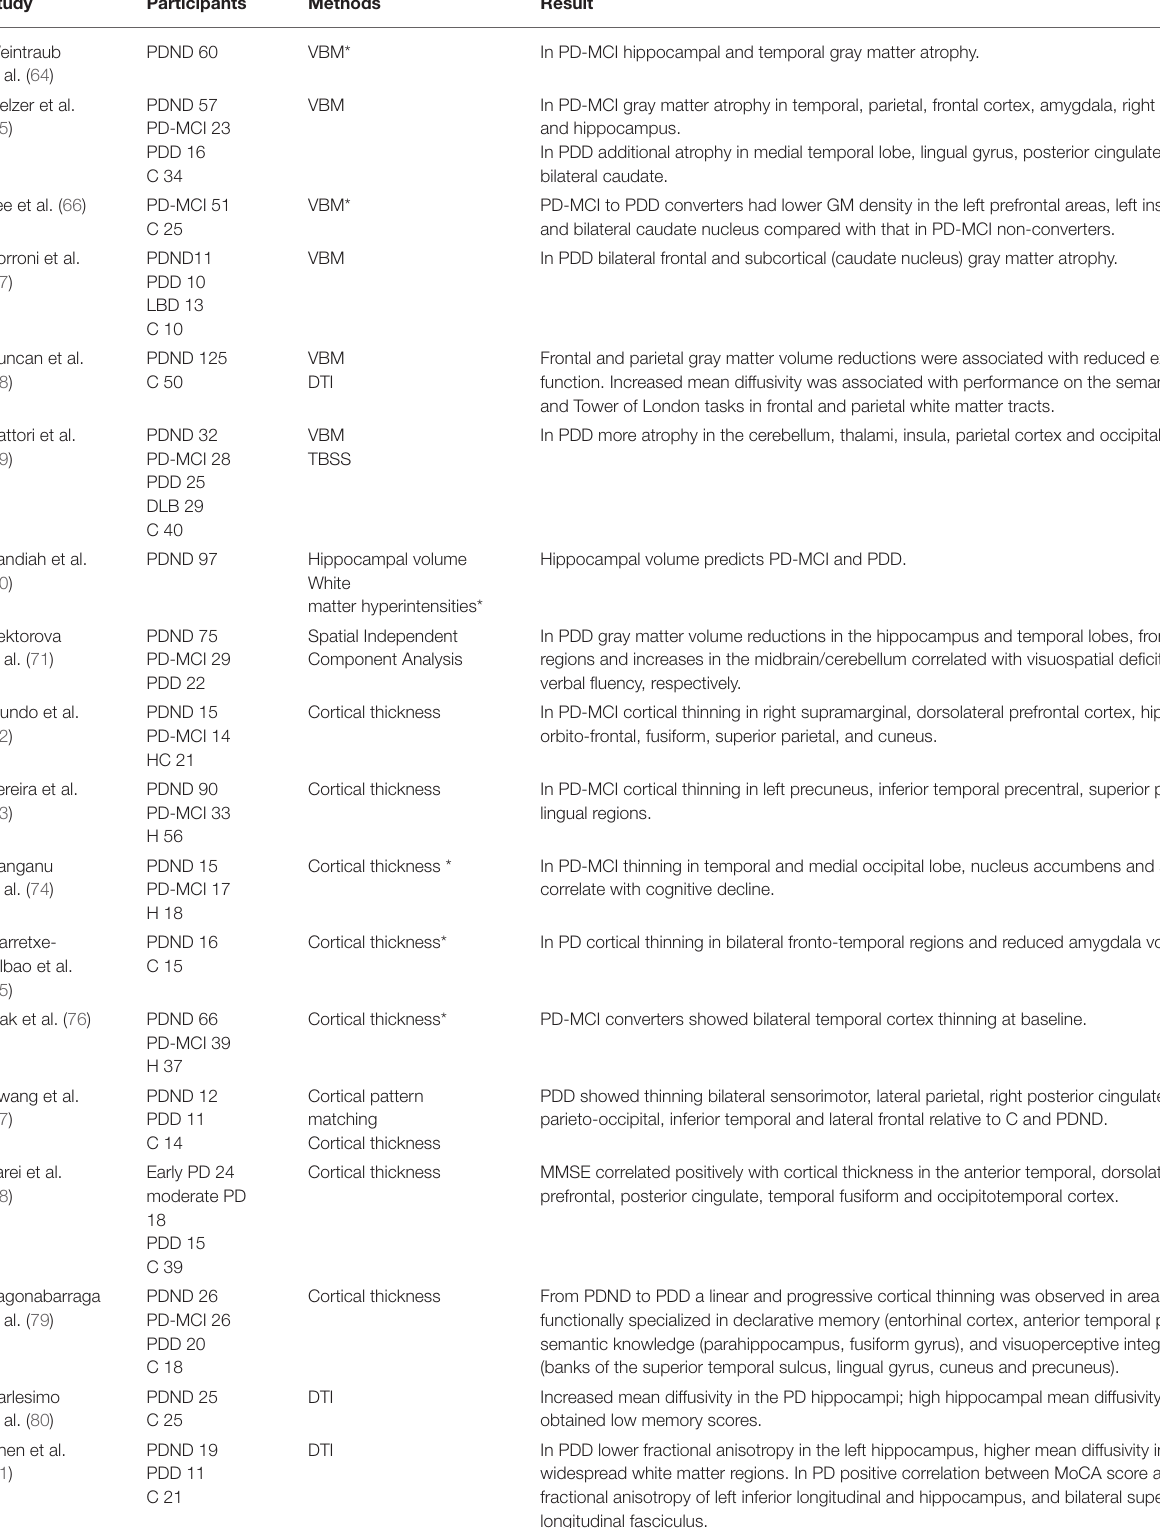
TABLE 2 | Cortical and subcortical structural changes related to cognitive impairment and dementia in Parkinson’s disease.